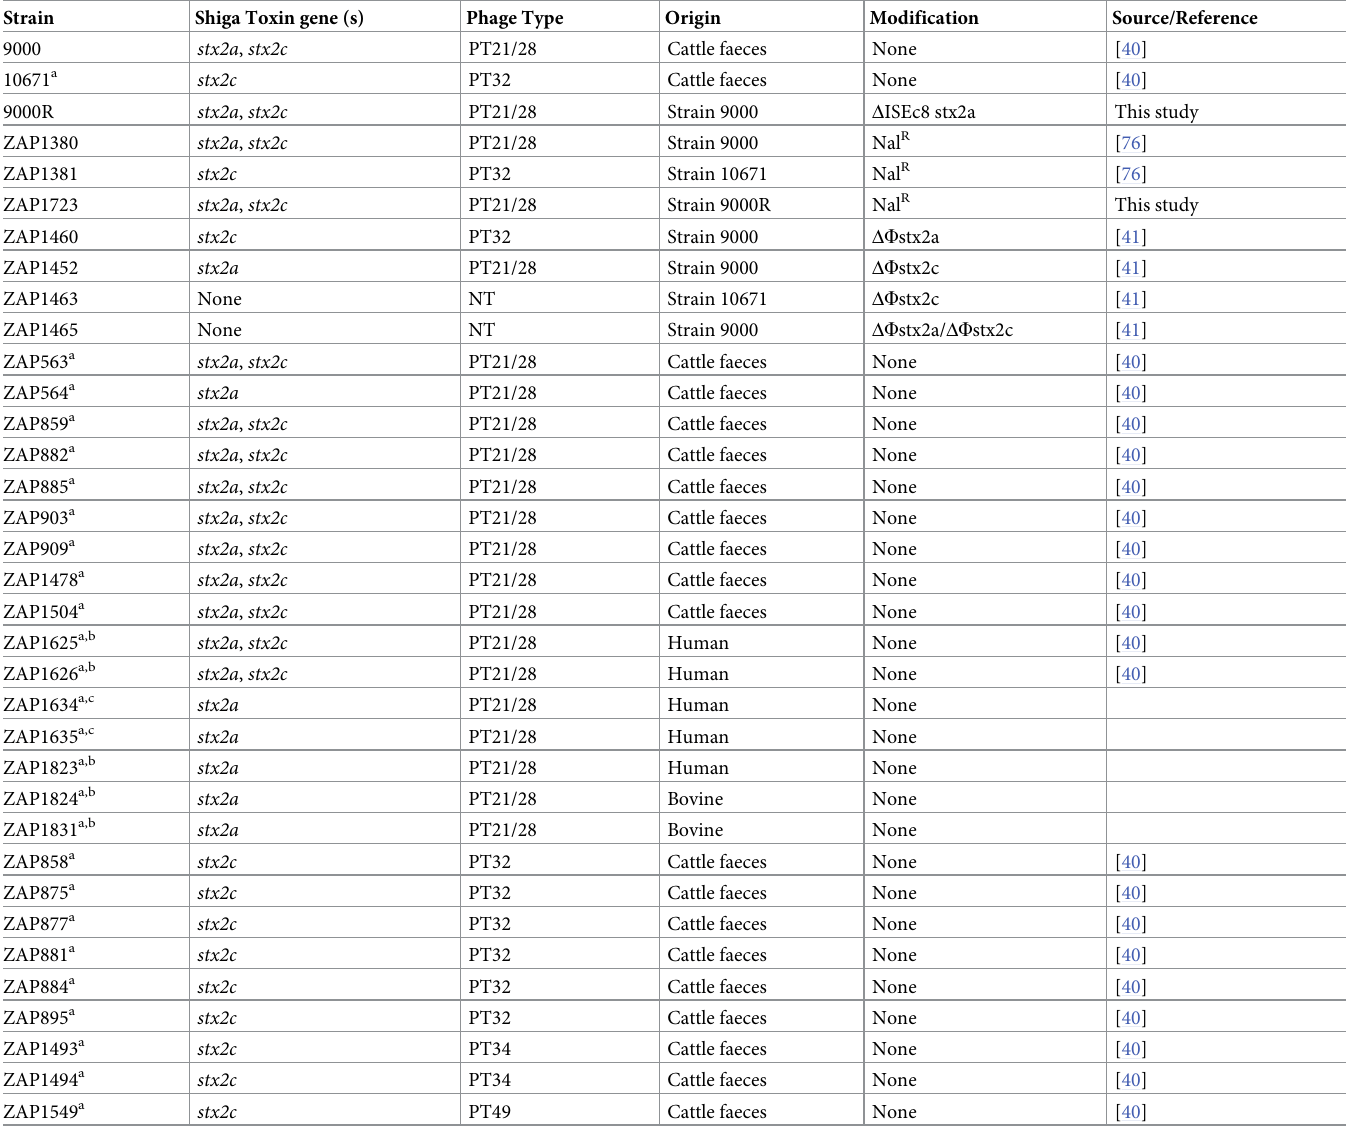
Table 1. Details of bacterial strains used in this